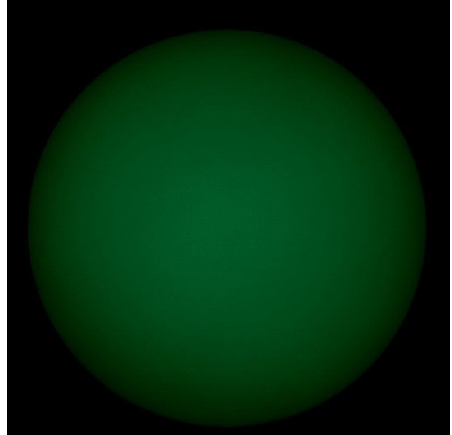
Figure 16. Photosphere seen through White